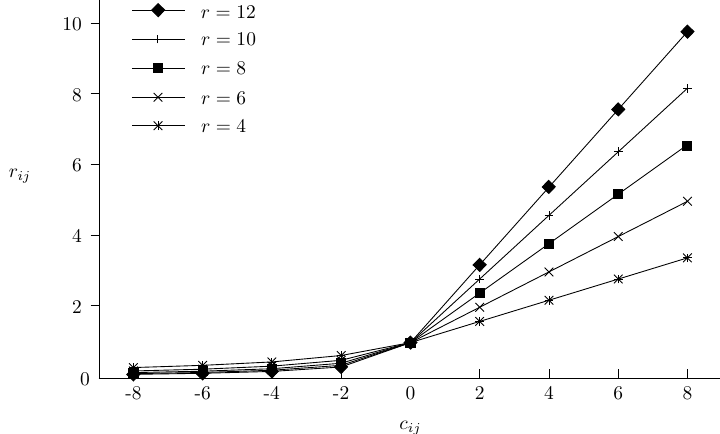
Figure 2: Relationship between the likelihood ratio and cross-impact